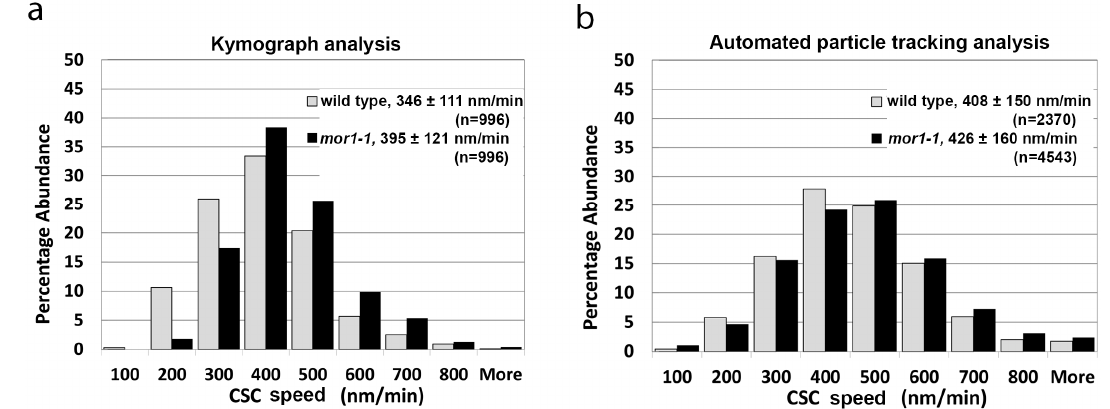
Figure 1. Automated particle tracking quickly and accurately measures fluorescent protein distribution and dynamics. ( a , b ) Histogram of cellulose synthase complex (CSC) velocity distribution in wild type and in mor1-1 recorded at 29 °C using kymograph analysis ( a ), and automated particle-tracking analysis ( b ). CSC velocity and speeds are significantly greater in mor1-1 compared to wild type ( p < 0.0001) for kymograph and particle-tracking analysis respectively. Values are means ± SD. See also Movies S1 and S2.